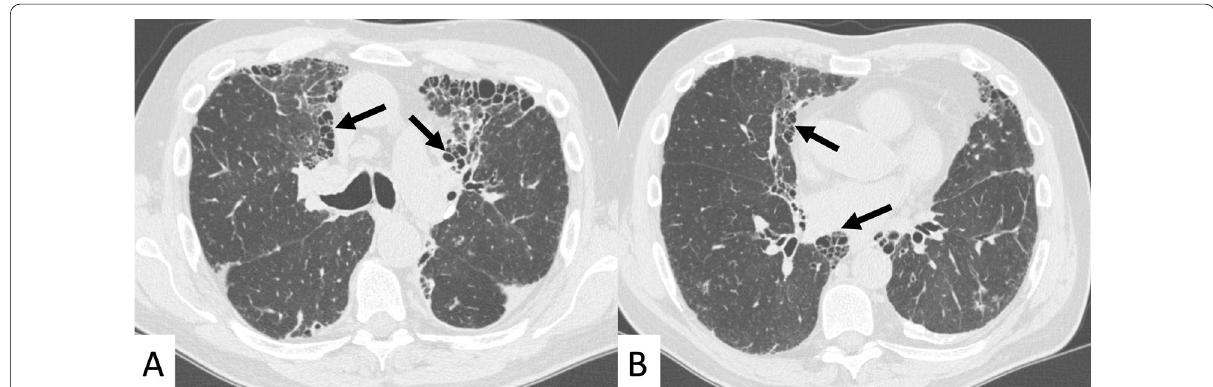
Fig. 27 A 77-year-old man with diagnosis of Sjöegren, achieved from histological samples of parotid glands. Cystic spaces are clearly depicted through the lung regions, with anterior and subpleural mediastinal location (black arrows in A , B ). Peripheral cystic areas have been associated with perilymphatic distribution of